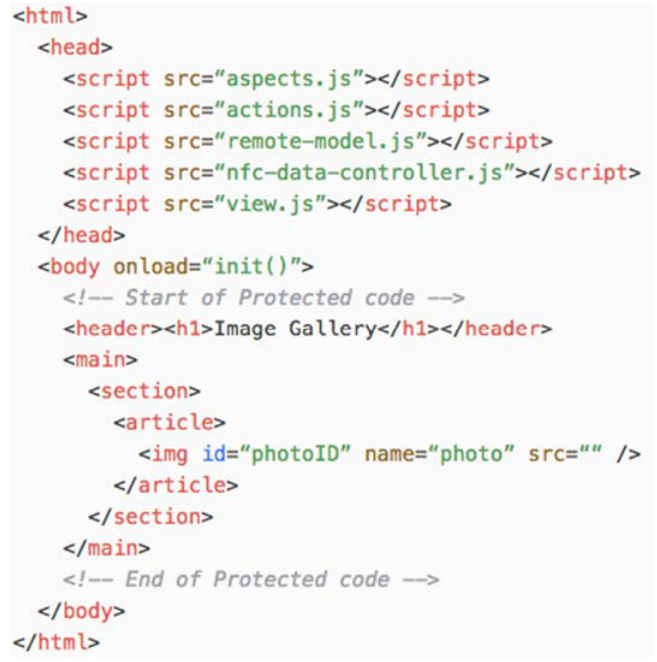
Figure 7. The HTML code for the view of the APGA UApp.